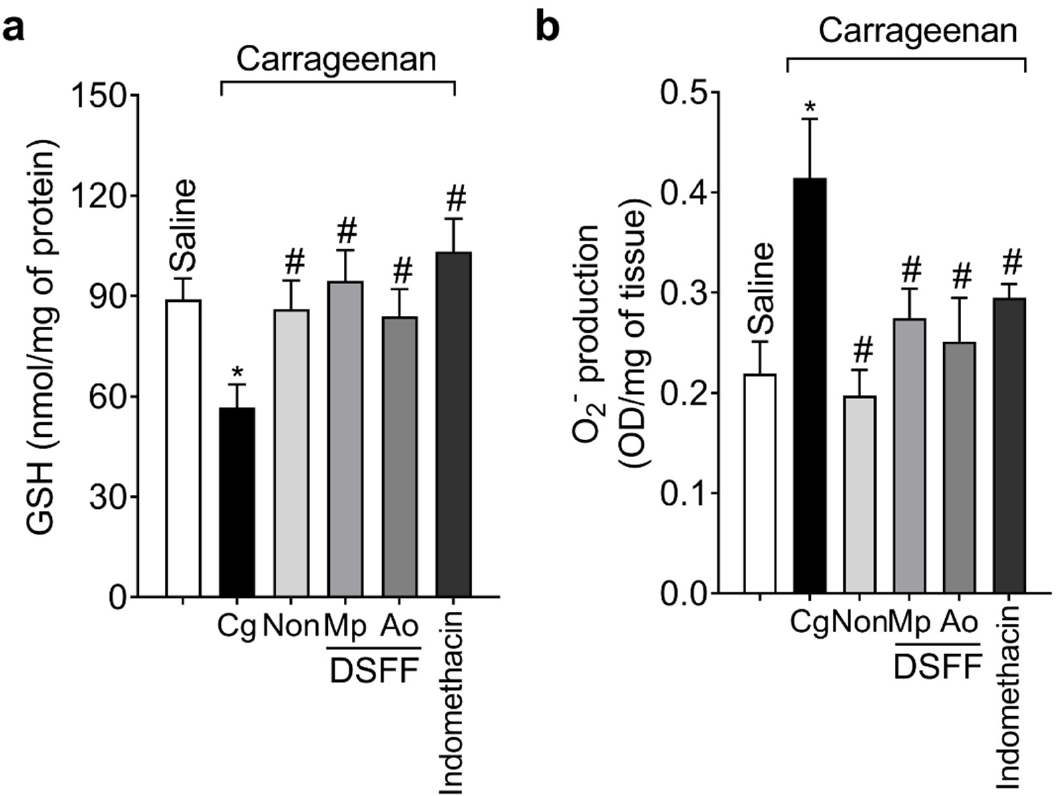
Figure 4. Evaluation of oxidative stress in carrageenan paw inflammation. DSF-Non, DSFF-Mp, and DSFF-Ao (30 mg/kg) extracts prevent ( a ) GSH reduction and inhibits ( b ) O 2 − production in the paw tissue. Indomethacin (5 mg/kg) was used as a positive control drug. GSH and O 2 − levels were determined 3 h after carrageenan i.pl. injection. Results are expressed as mean ± SEM of six mice per group per experiment and are representative of two independent experiments. * p < 0.05 vs. saline group; # p < 0.05 vs. carrageenan group.